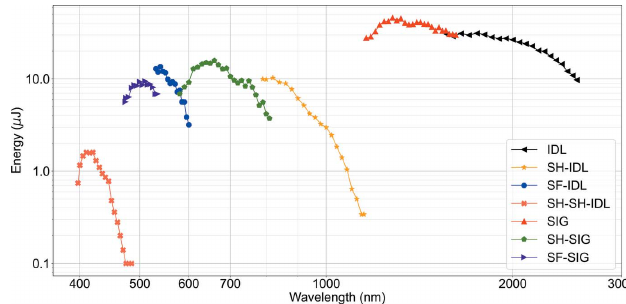
Figure 6 Output of TOPAS at different wavelengths. For this measurement, TOPAS was pumped by the PP laser with the following parameters: 800 nm, (cid:6) 54 fs, 215 m J and 50 pulses per train at 1.1 MHz. (SH – second harmonic; SF – sum frequency; SIG – signal; IDL –